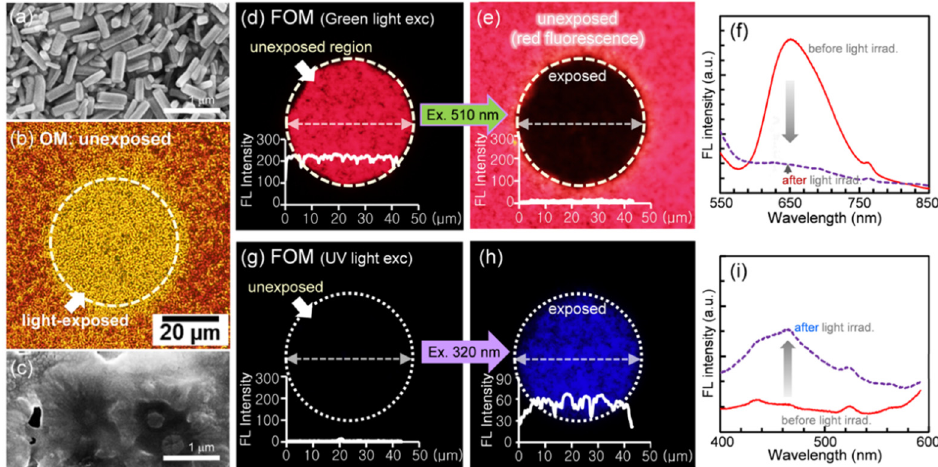
Figure 7. Light-responsive hexagonal nanorods. ( a , c ) SEM and ( b ) optical microscopy (OM) images taken ( a ) before and ( c ) after irradiation with UV light. Fluorescence optical microscopy (FOM) images taken by excitation with ( d , e ) green light and ( g , h ) UV light. Fluorescence spectral changes ( f : excited at 510 nm, i : excited at 320 nm) of hexagonal rods placed on quartz plate before and after light irradiation. ( h , i ) The UV-exposed sample showed very weak blue fluorescence.